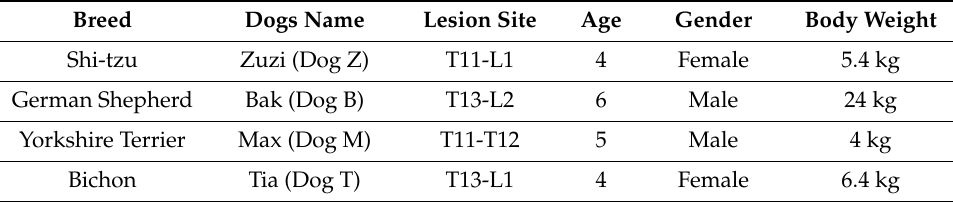
Table 3. An overview of dogs enrolled in the